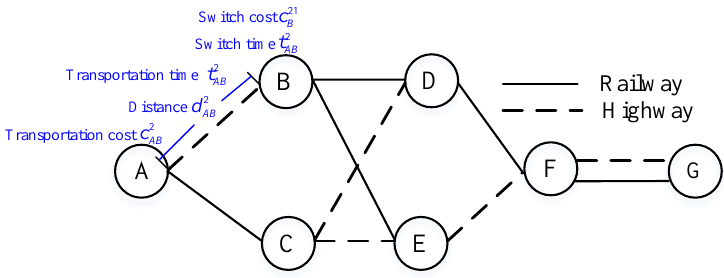
Figure 1. Network diagram of random path layout for multimodal